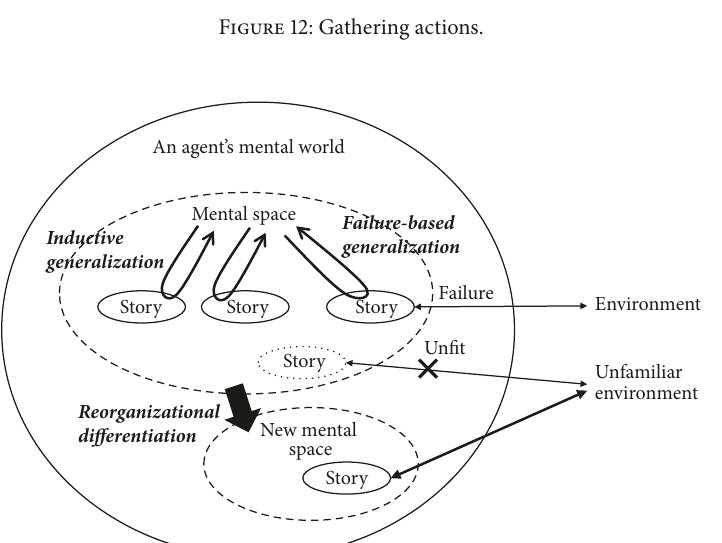
Figure 12: Gathering actions.